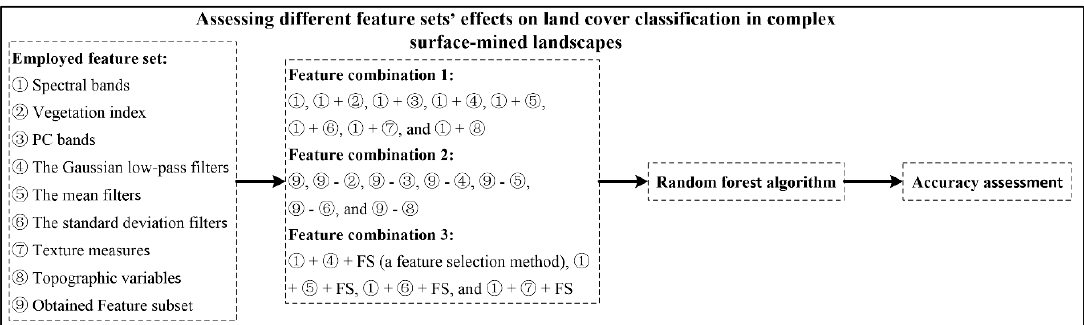
Figure 3. Flow chart of the feature set combinations and classification procedure.